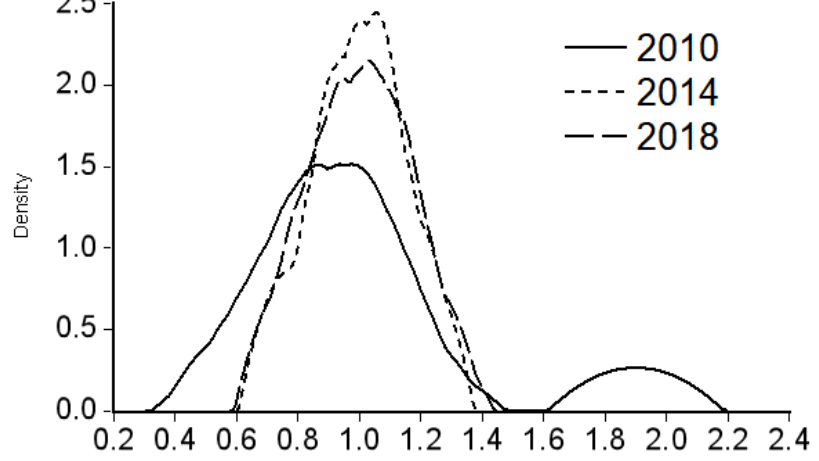
Figure 3. Kernel density estimation of the number of health personnel per 10,000 people in the eastern economic belt provinces.